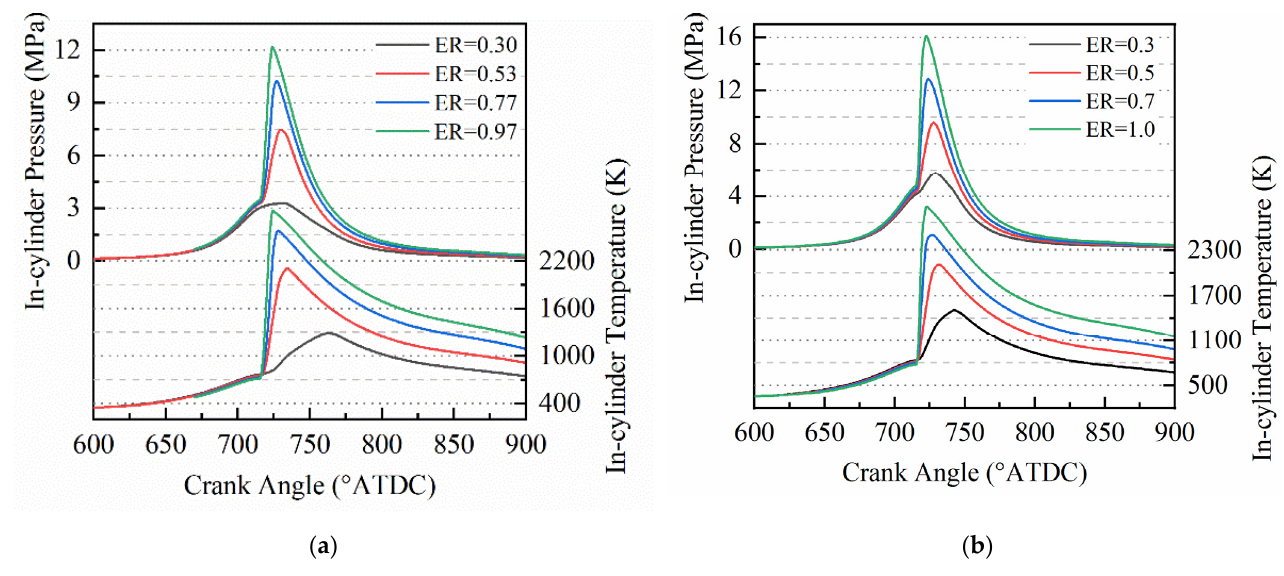
Figure 3. In-cylinder pressure and temperature curves for different equivalence ratios [48]. ( a ) CR = 12. ( b ) CR = 15.